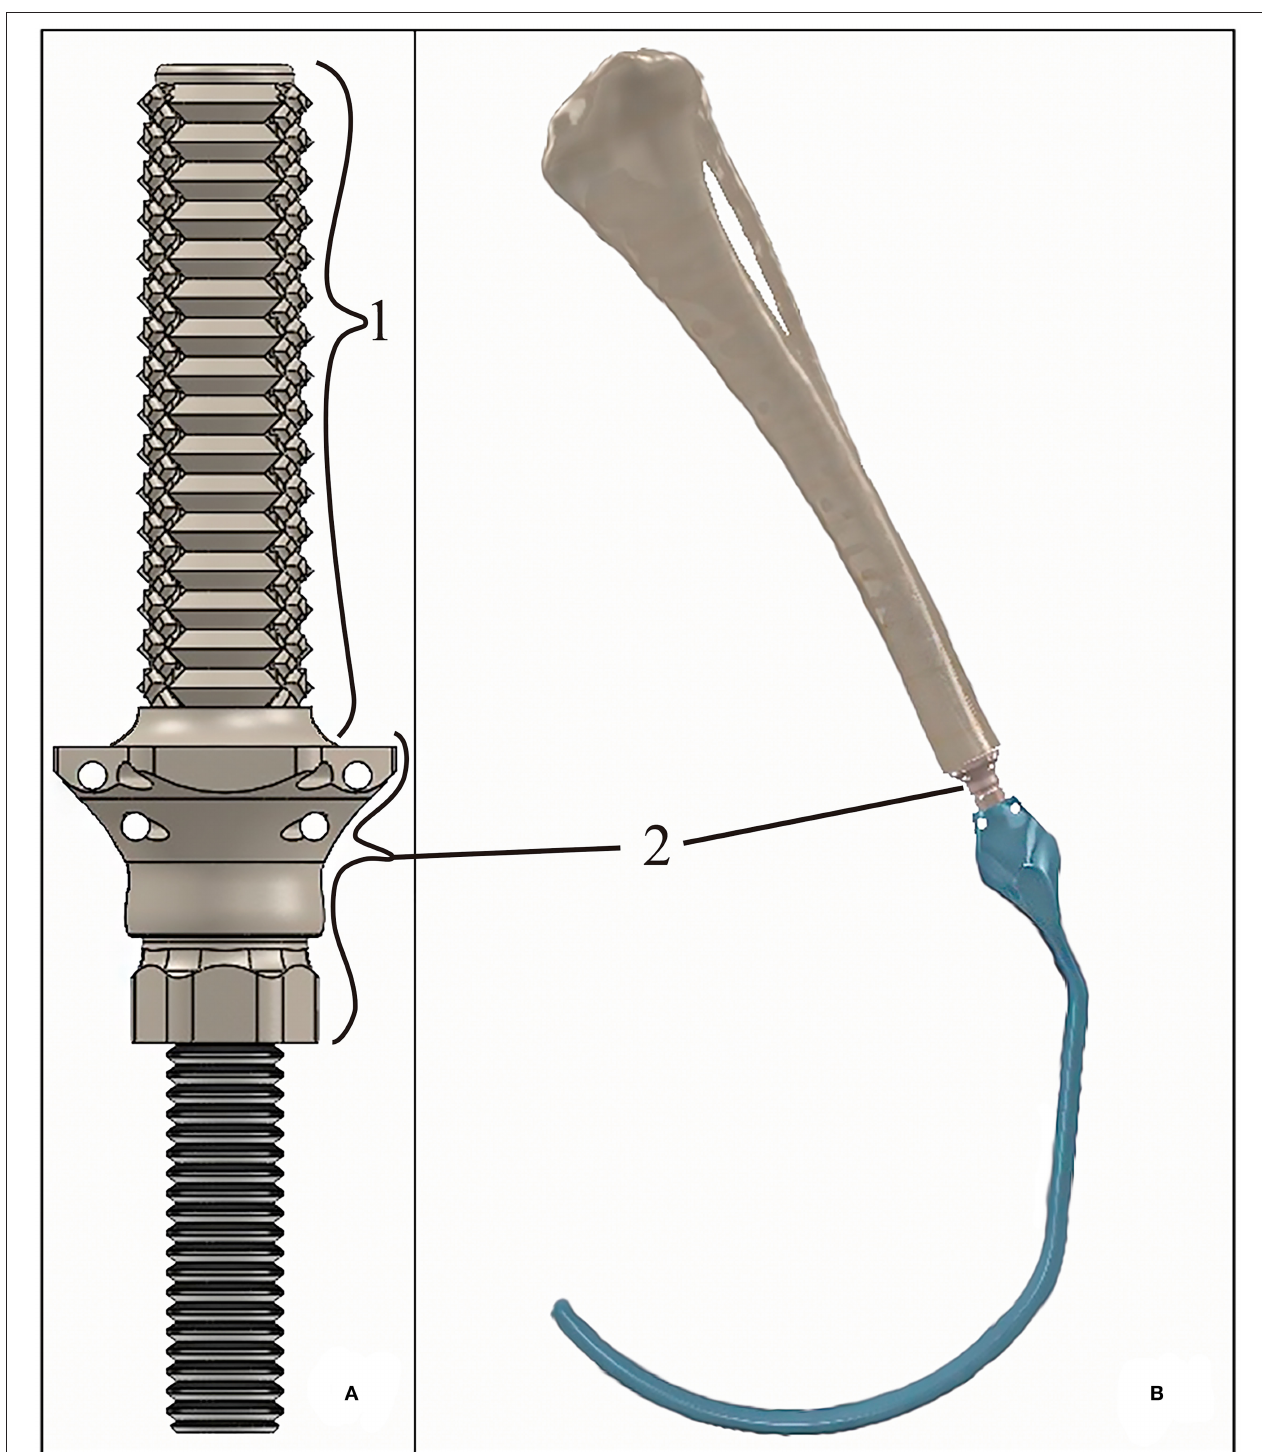
FIGURE 1 | (A) 3D-rendered model of the tibial endoprosthesis and (B) 3D-rendered assembly of the exo-endoprosthesis inserted into a tibia. The exo-prosthesis part (blue) is an example of the ideal construct. Where (1) represents the stem; and (2) represents an approximation base- “umbrella” section.